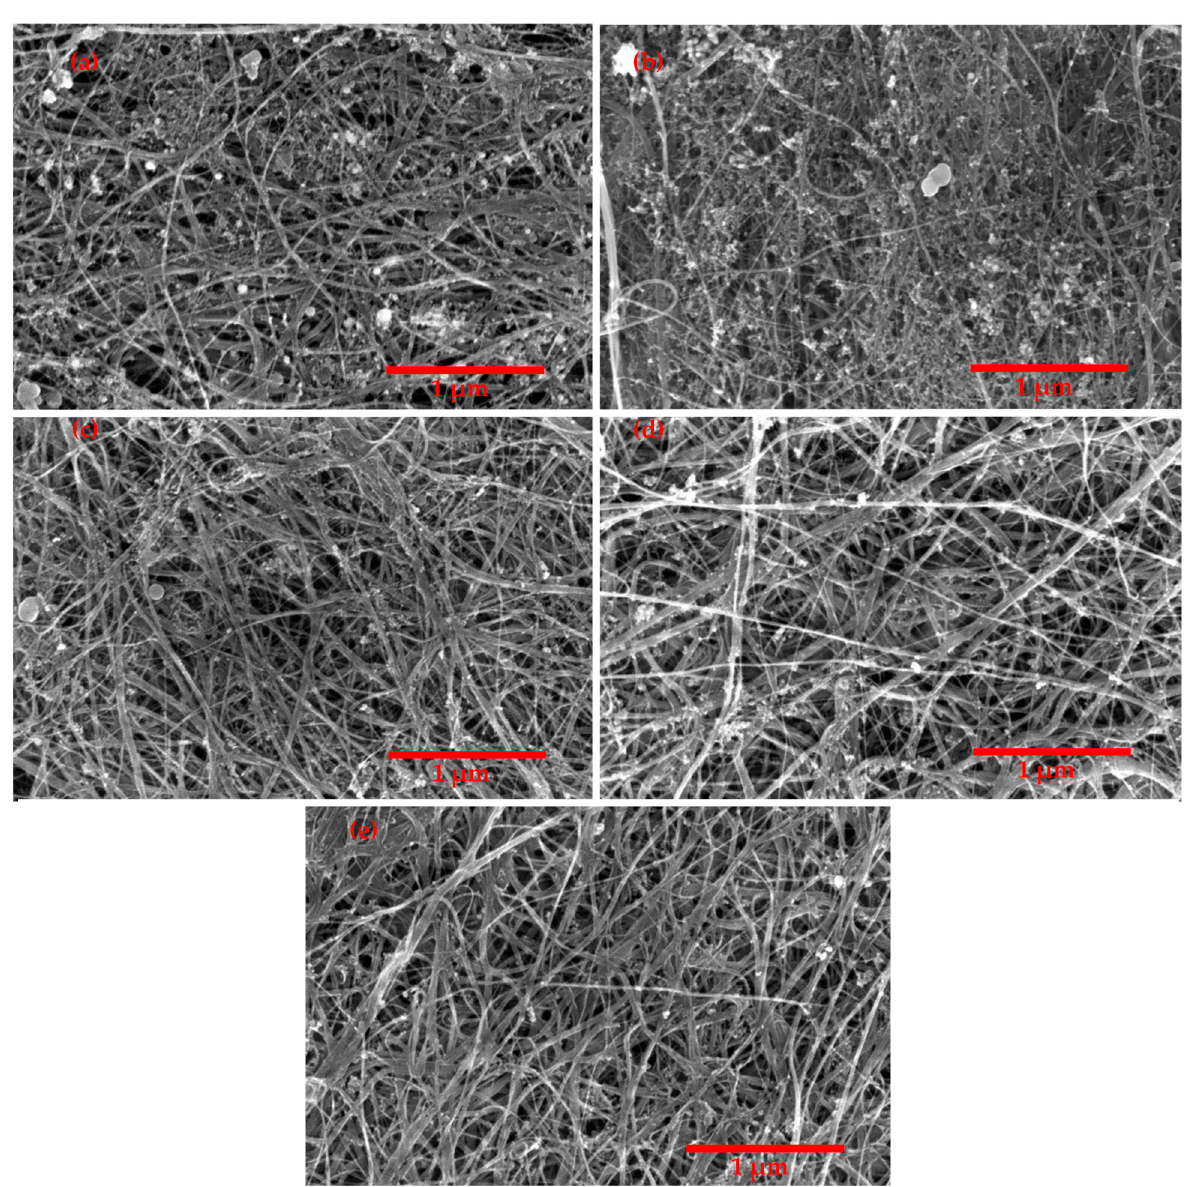
Figure 4. SEM images of the CNT sheet samples from the following fuel types: ( a ) Fuel I, ( b ) Fuel II, ( c ) Fuel III, ( d ) Fuel IV, ( e ) Fuel V.